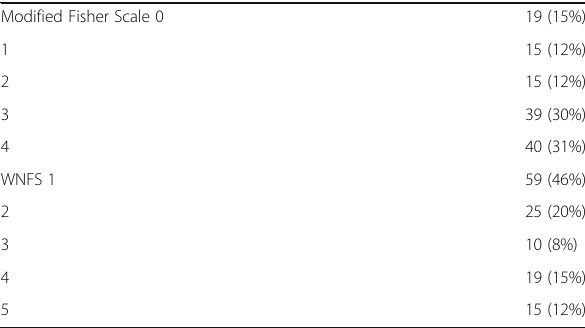
Table 2 (abstract 0364). Baseline characteristics